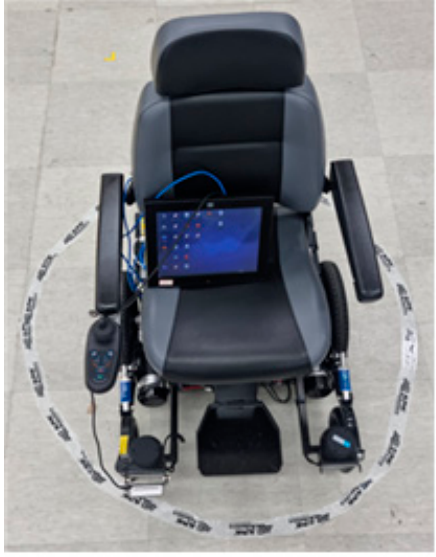
Figure 12. Circle with target turning radius.